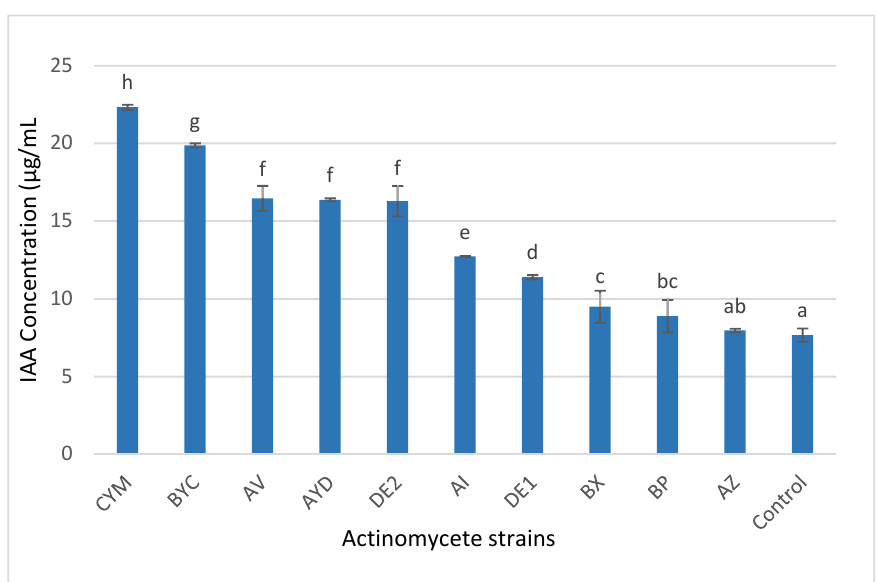
Figure 5. Concentration of indole acetic acid released (µg/mL) in the non-inoculated flasks (control) and in the supernatant of cultures of the ten selected Actinomycete strains grown for 72 h in liquid LB medium containing L-tryptophan (1 g/L). After addition of 2 mL of Salkowski’s reagent, the formation of the pink color indicated the presence of IAA and the IAA concentration produced was estimated by measuring the OD at 530 nm after 30 min of incubation in the dark. Error bars represent standard deviations of the mean values of the results of three independent culture replicates. Different lowercase letters above bars shows significant differences between treatments at p ≤ 0.05.